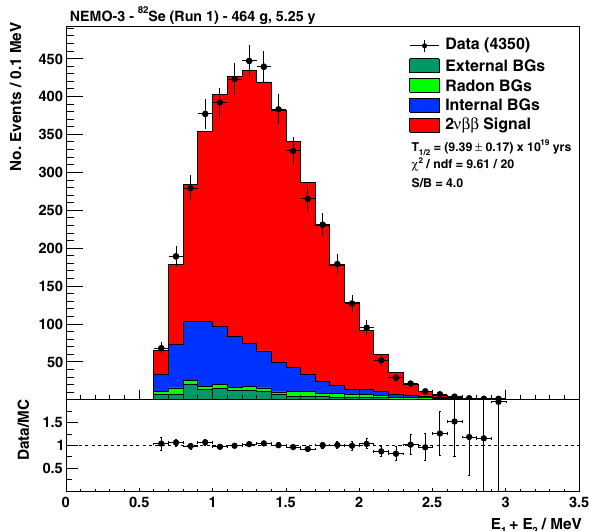
Fig. 8 Distribution of the summed energy of the two electrons in the ββ channel originating from enrichment run 1 foils. Data are compared totheMCprediction,wheretheactivitiesofbothsignalandbackground componentsaretakenfromthebinnedlog-likelihoodfit.Thenumbersof events in the histogram are as shown in Table 2. The largest background category is internal contamination of the source foil (blue), but this is still much smaller than the contribution from the 2 νββ signal, with a signal-to-background ratio of 4.0